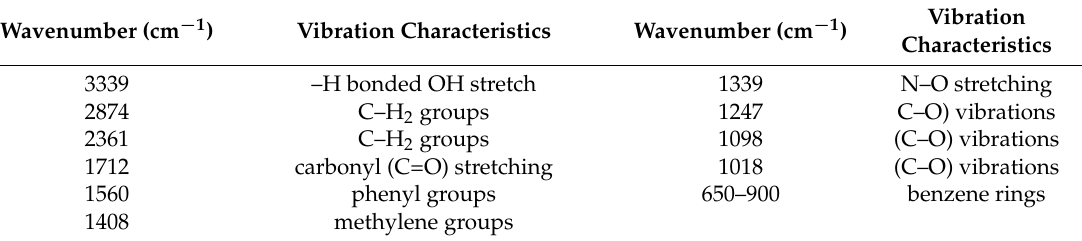
Figure 3. Fourier transform infrared (FTIR) spectra of the samples at different pH. Table 2. Infrared vibration from FTIR analysis.